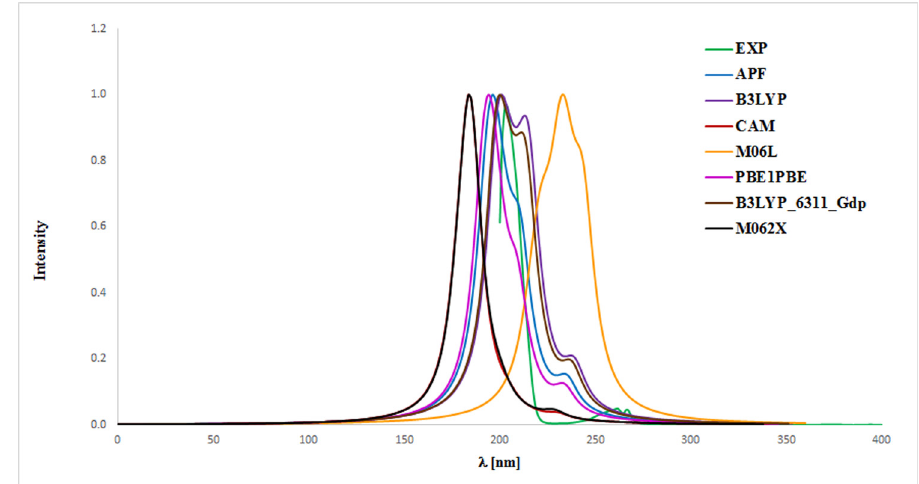
Figure 7: Experimental ( EXP ) and theoretical UV - vis spectra of fl uconazole 2 registered in methanol and computed using CPCM solvation model ( methanol as solvent ) ; approximations: APF – APF/6 - 311 ++ G ( 2d,3p ) //APF/6 - 31G ( d,p ) , B3LYP – B3LYP/6 - 311 ++ G ( 2d,3p ) //B3LYP/6 - 31G ( d,p ) , CAM – CAM - B3LYP/6 - 311 ++ G ( 2d,3p ) //CAM - B3LYP/6 - 31G ( d,p ) , M06L – M06L/6 - 311 ++ G ( 2d,3p ) //M06L/6 - 31G ( d,p ) ,